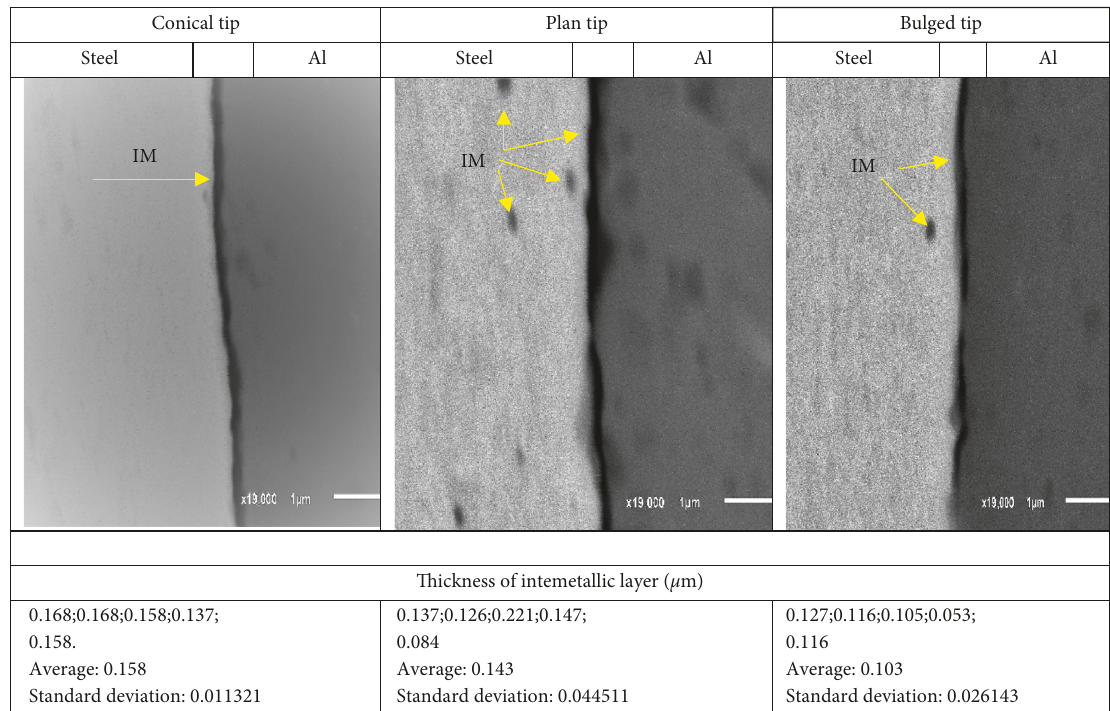
Figure 9: Intermetallic layer formed in the friction